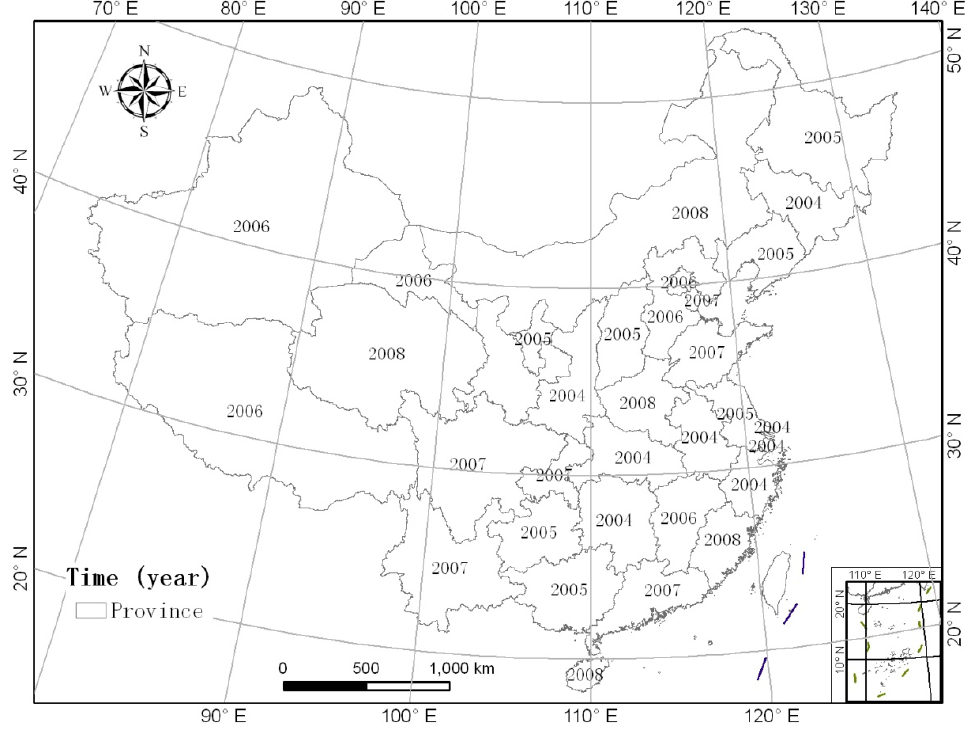
Figure 2. Specific forest inventory times for each province from